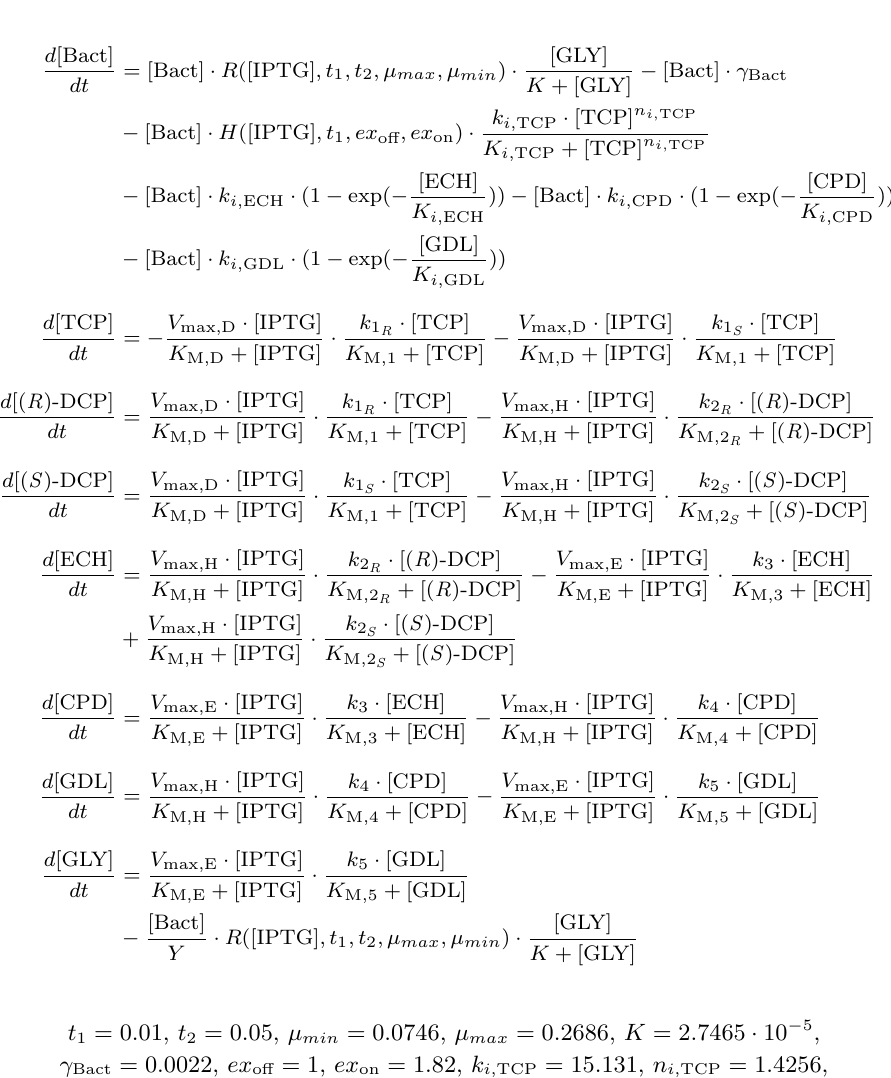
, k 1 , k 2 , k 2 , R S R S